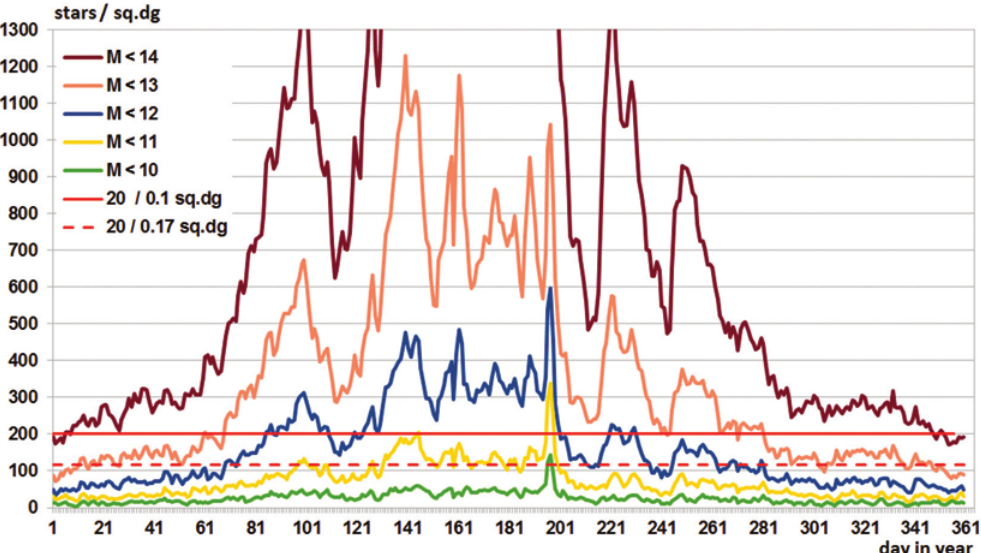
Fig. 2. Star distribution density near zenith at midnight UT for site with 57dg latitude and 24 dg